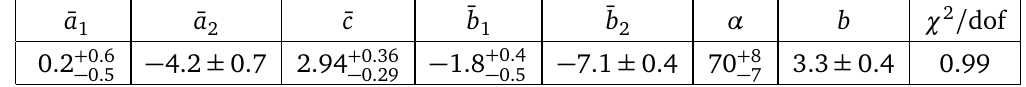
]= GeV − 2 ) and χ 2 / dof. ij